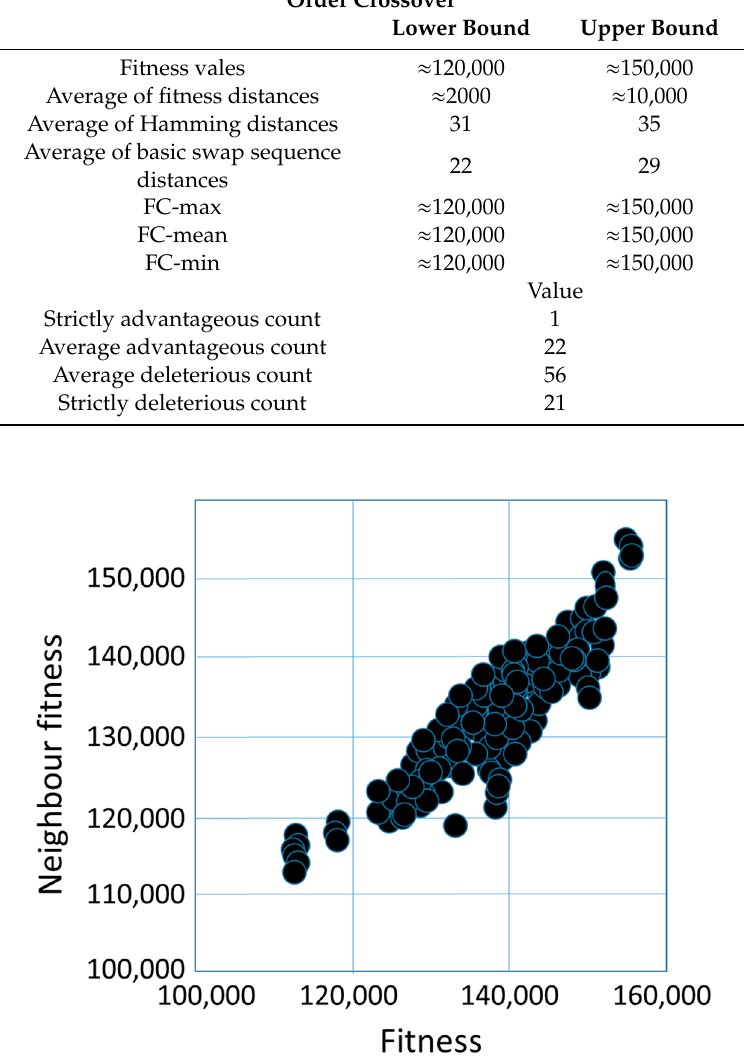
Figure 10. The fitness cloud for cycle crossover operator. Table 8. Cycle crossover distances results.